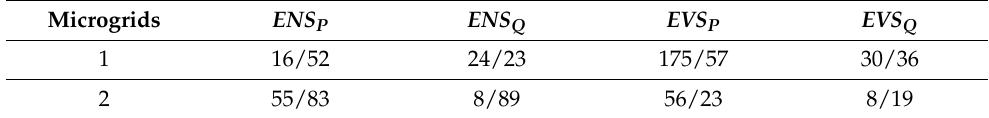
Table 8. Expected unmet energy supply (in terms of MWh and MVArh ) due to lack of active and reactive power.